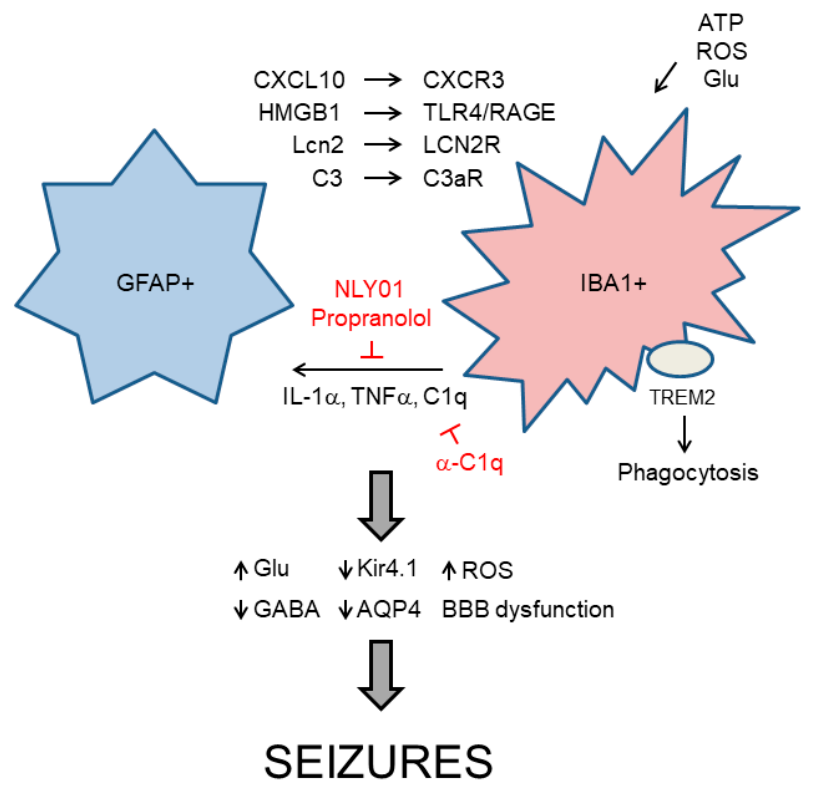
Figure 6. Functional relationship between GFAP + (glial fibrillary acidic protein) reactive astrocytes and IBA + (ionized calcium-binding adapter molecule) activated microglia. Reactive astrocytes produce critical components that activate microglia (e.g., CXCL10, HMGB1, Lcn2, C3, etc.). These components are recognized by specific microglial receptors (CXCR3, TLR4 / RAGE, LCN2R, C3aR, respectively) that trigger signaling cascades leading to microglia activation. Microglia can also get activated by increases in the levels of ATP, reactive oxygen species (ROS), or glutamate in the medium. Activated microglia produces IL-1 α , TNF α , and C1q, which transform resting astrocytes into type A1 reactive astrocytes. Therapeutic strategies to prevent this action are in red. In addition, activated microglia participates in the phagocytosis of neurons using specific receptors (e.g., TREM2—triggering receptor expressed on myeloid cells 2) that recognize specific “eat-me” signals. As a consequence of astrocyte and microglia reactivity, critical mediators in glial physiology are altered, leading to seizures. Pointed arrows indicate direction of the signaling pathway. Blunt arrows indicate inhibition.